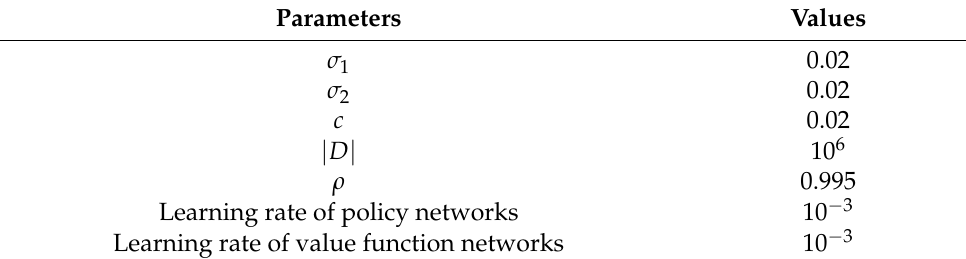
Table 3. Parameter settings of TD3.